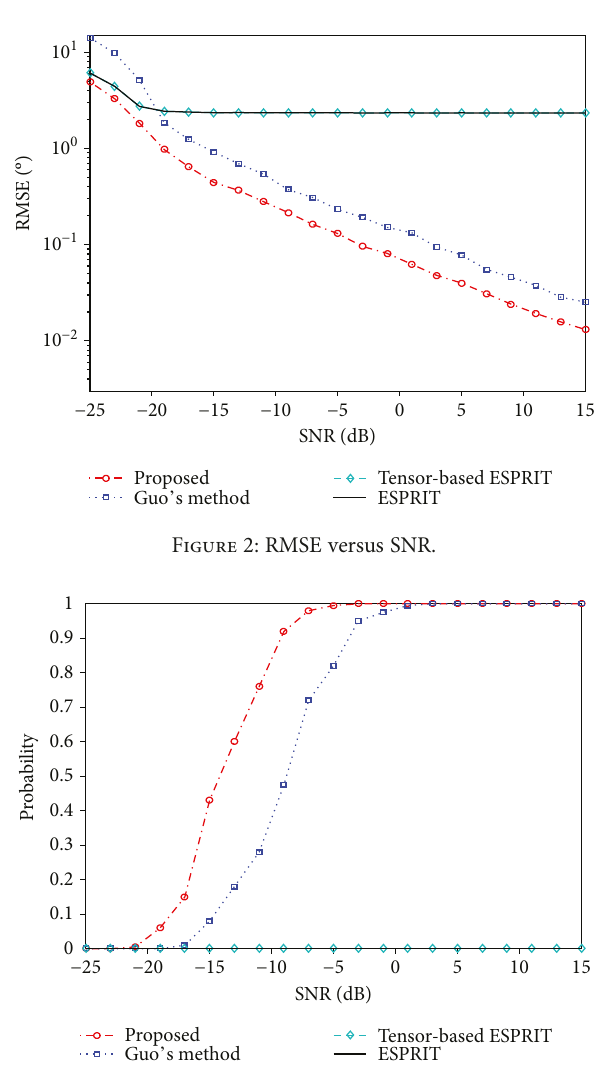
Figure 3: Probability of successful detection.